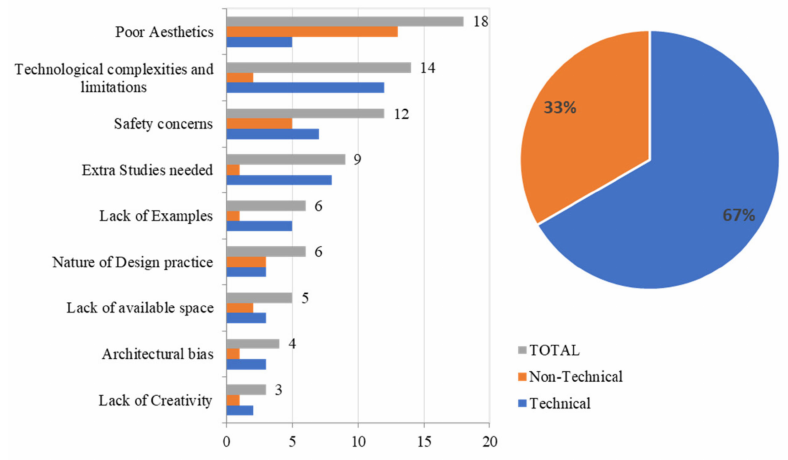
Figure 4. Design barrier sub-themes with the number of participants who